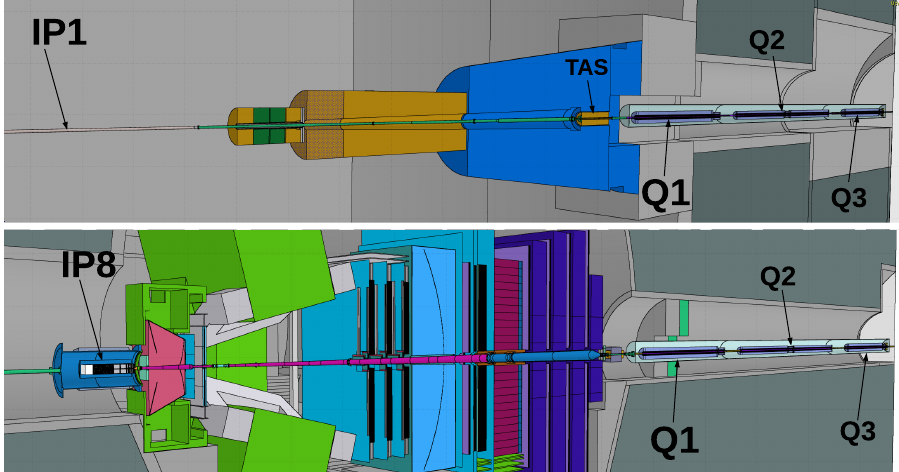
FIG. 15. Geometry models of the ATLAS (top) and LHCb (bottom) experimental regions. The first model includes only the forward calorimeter, forward shielding, and absorbers, while the latter model includes also the entire detector. The triplet quadrupoles (Q1, Q2, and Q3) can be seen on the right side. The interaction points (IPs), where the two beams collide, are located on the left.